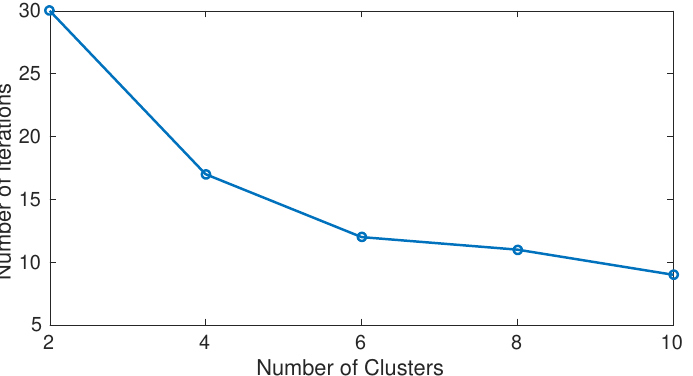
Figure 2. Number of iterations to converge to a stable possibility distribution with 120 tasks and clustered